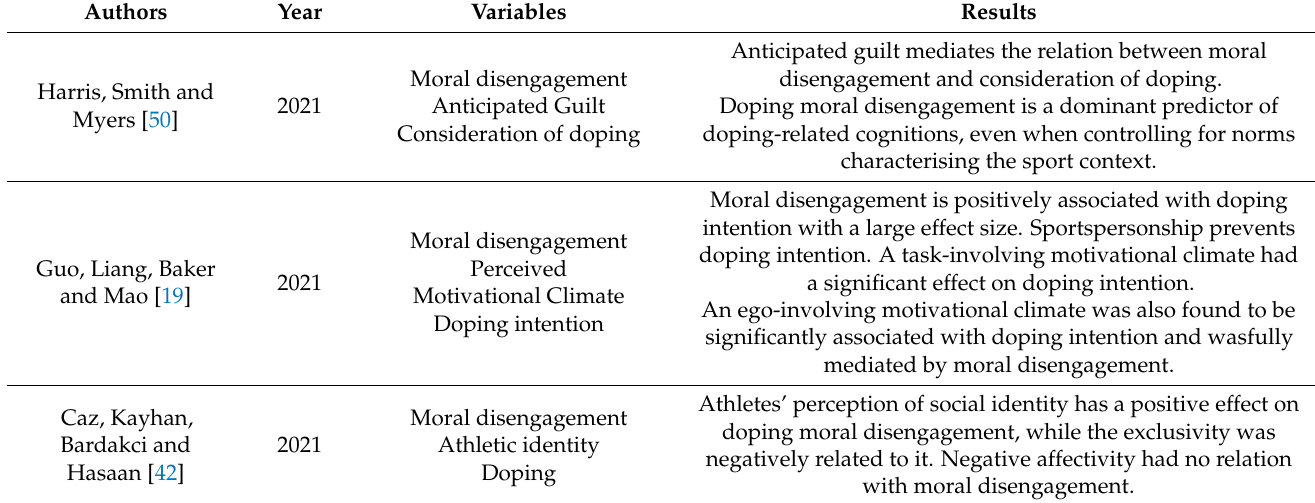
Table 1. Studies on moral disengagement as predictor of doping behaviour published between 2012 and